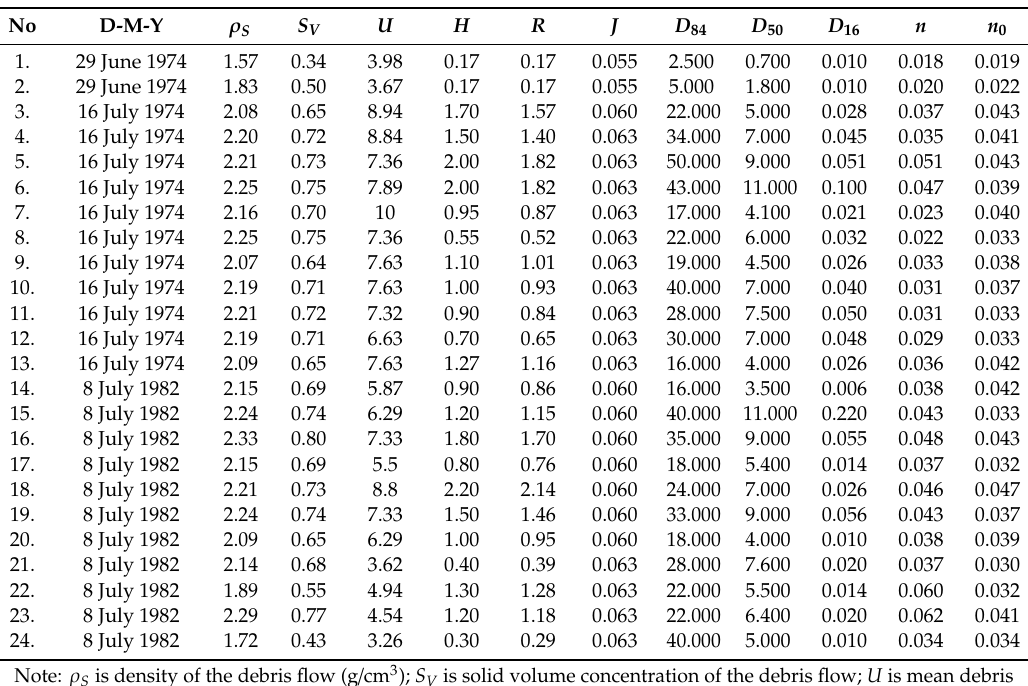
Table 2. Observation data for the Jiangjia Gully in Dongchuan Debris Flow Observation Station (DDFORS).